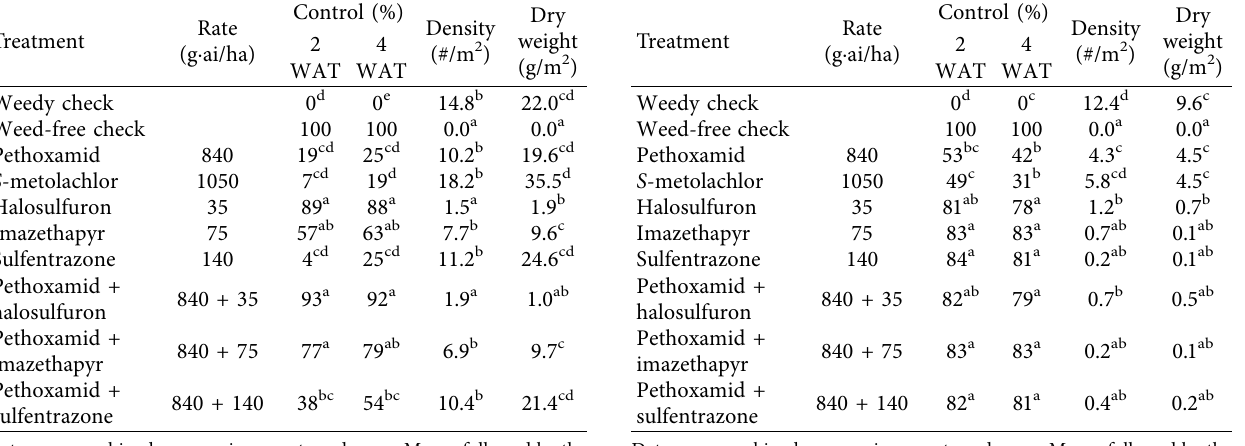
Table 3: Percent control, density, and dry weight of common ragweed 2 and 4 weeks after herbicide treatment (WAT) in white bean treated with pethoxamid applied PRE in 2015, 2016, and 2017. Treatment